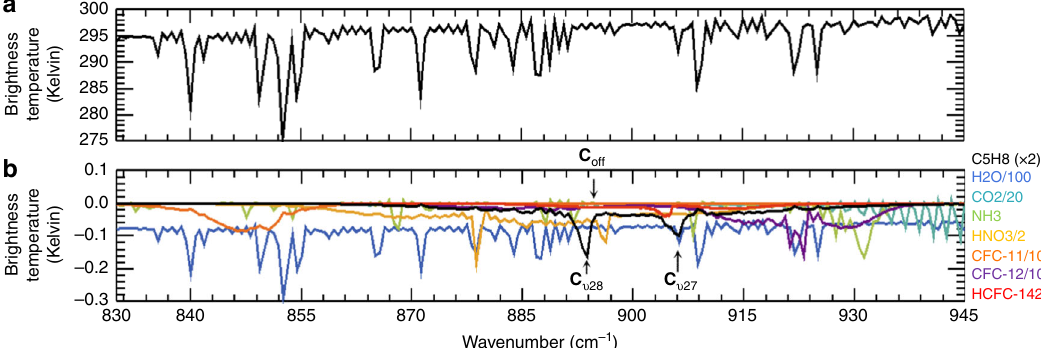
Fig. 1 Example CrIS spectrum and relevant speciated spectral features. a An individual CrIS-measured spectrum (black line) in the region of isoprene ’ s ν 27 and ν 28 bands, obtained over Amazonia (8.698°S, 69.134°W) on September 30, 2014. The major features are associated with H 2 O vapor. b Spectral contributions from isoprene (C 5 H 8 ), water vapor (H 2 O), carbon dioxide (CO 2 ), nitric acid (HNO 3 ), ammonia (NH 3 ), and chloro fl uorocarbons (CFC-11 and CFC-12) for the same scene. C ν 28 : spectral channel near the peak of isoprene absorption for the ν 28 band. C off : closest spectral channel to C ν 28 that is near the continuum featuring no isoprene absorption. Spectral features for H 2 O, CO 2 , HNO 3 , CFC-11, and CFC-12 have been divided by 100, 20, 2, 10, and